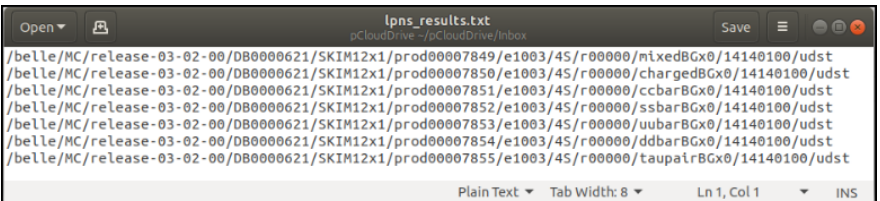
Figure 4: Overview of the main GUI panels that users interact